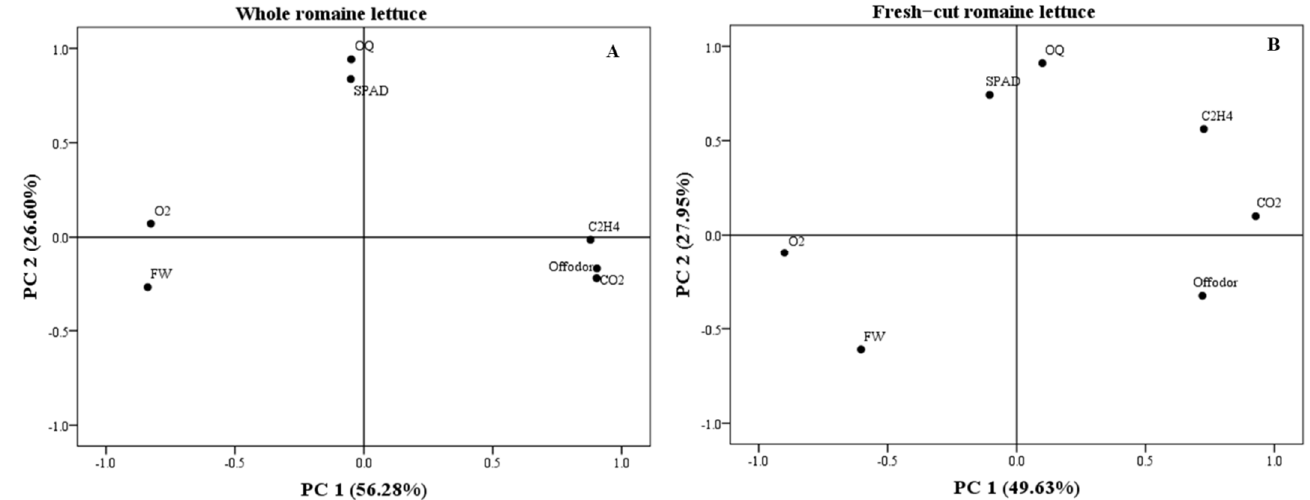
Figure 5. Plot of loadings for the response of whole ( A ) and fresh-cut ( B ) romaine lettuce at 15 days after MA storage at 2 and 8 ◦ C from PCA. FW: fresh weight loss rate, O 2 : oxygen concentration, CO 2 : carbon dioxide concentration, C 2 H 4 : ethylene concentration, SPAD: chlorophyll contents, and OQ: overall quality. Table 5. Correlation of variables to the factors of PCA based on factor